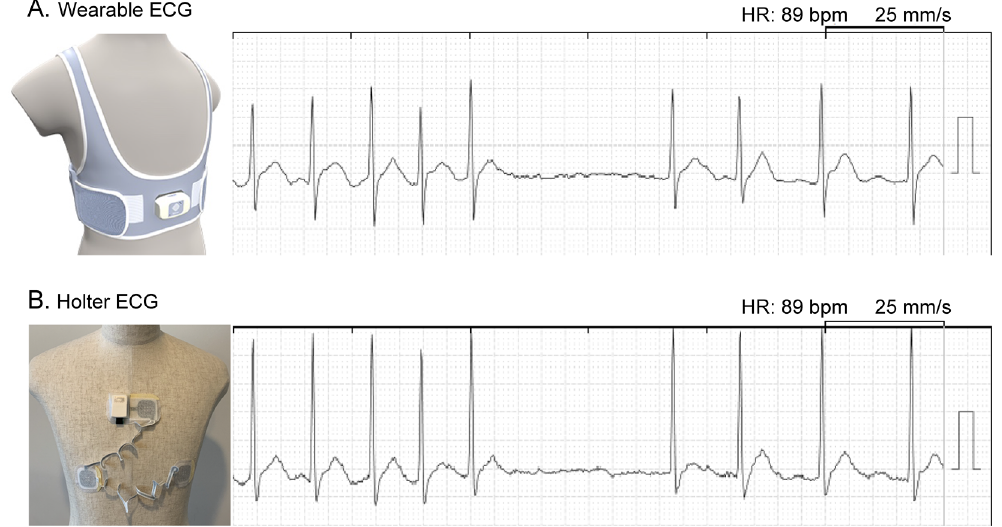
Figure 2. Simultaneous tracing from wearable ECG (A) and Holter ECG (B). Electrodes were positioned to compose a bipolar lead CC5 in both ECG devices. ECG, electrocardiogram; HR, heart rate.